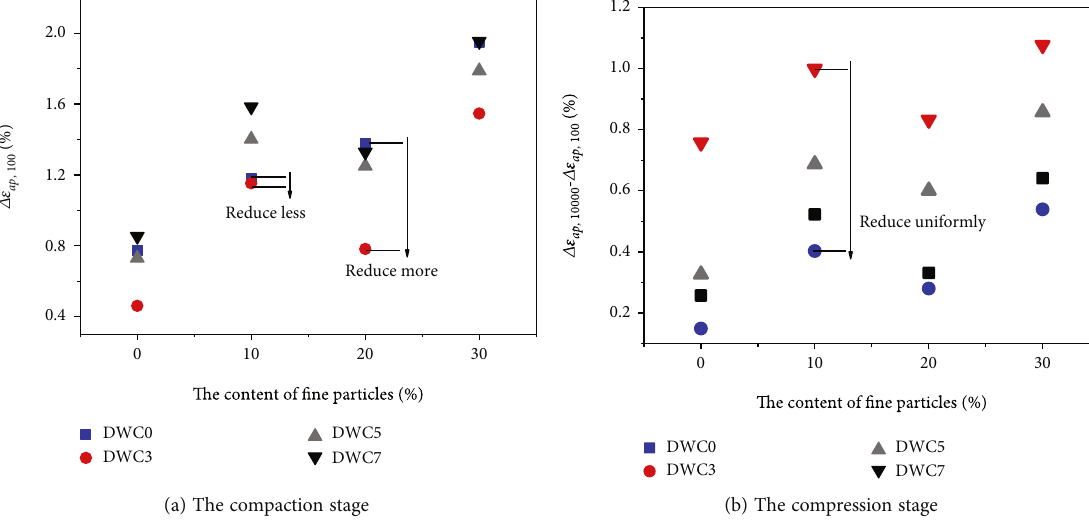
Figure 15: Comparison of permanent axial strain in two stages of